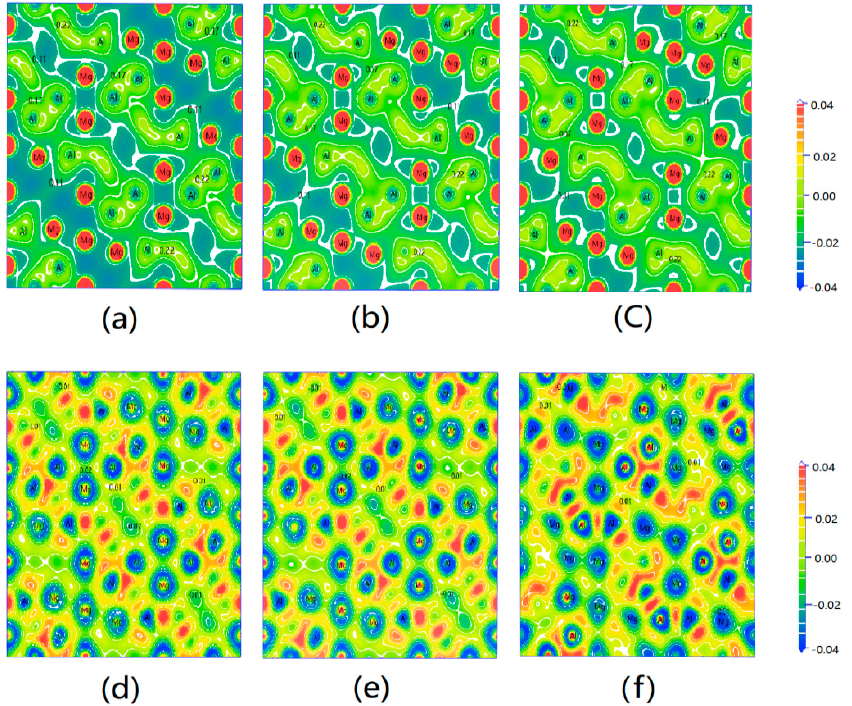
Figure 5. Charge density distribution maps ( a ), ( b ) and ( c ) of Mg 23 Al 30 at 0GPa, 4GPa and 8GPa, and differential charge density distribution maps ( d ), ( e ) and ( f ).